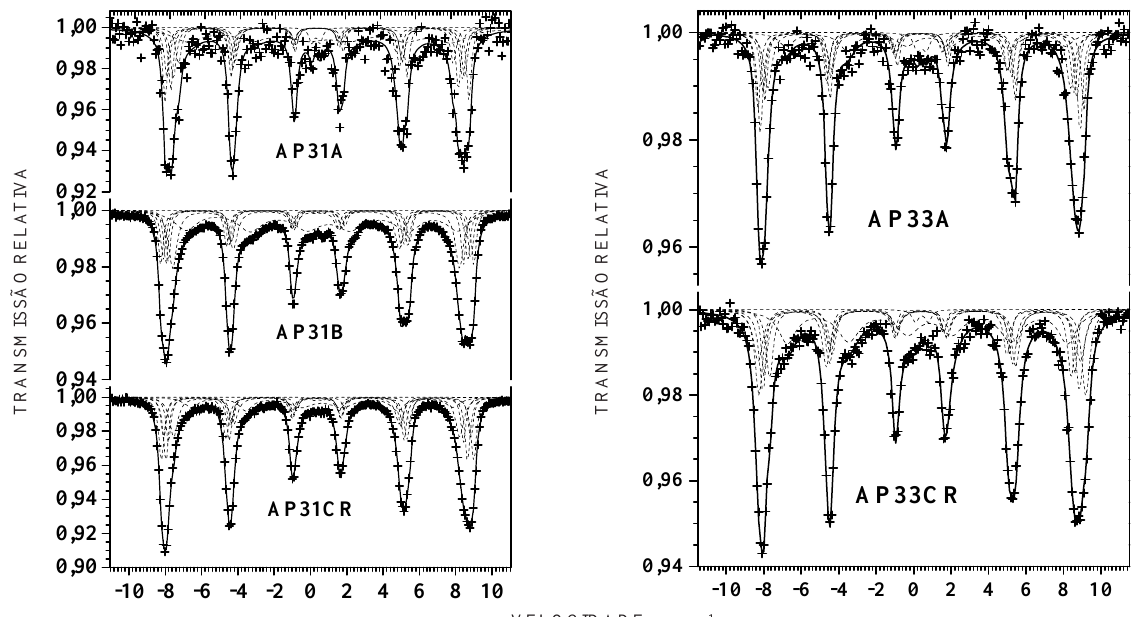
Figura 7. Espectros Mössbauer obtidos a aproximadamente 110 K (criostato de nitrogênio líquido) para as amostras de concentrados magnéticos das frações areia do perfil AP31 (esquerda) e perfil AP33